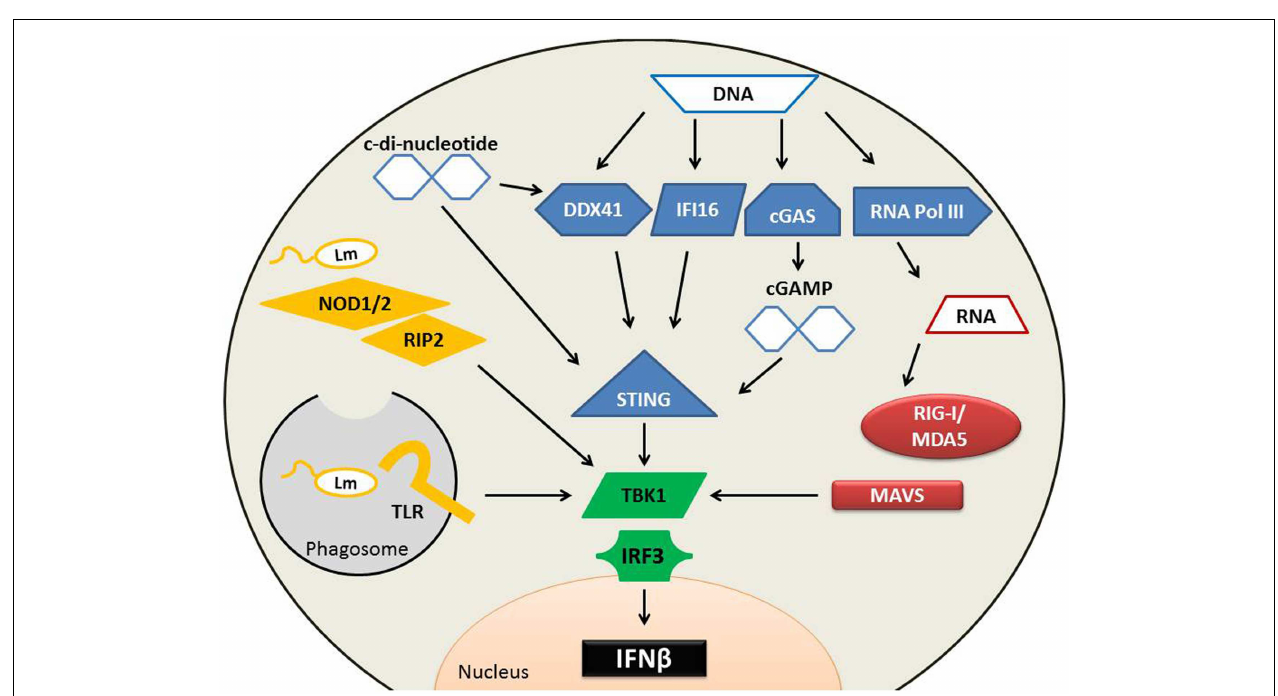
FIGURE 1 | Pathways implicated in type I IFN production following L. monocytogenes infection . Several cytosolic receptors are able to recognize L. monocytogenes (Lm) microbial components to induce type I IFN production. (Yellow) EndosomalTLRs recognize a variety of Lm bacterial patterns including cell wall fragments, which can also stimulate NOD proteins. NOD proteins require association with RIP2 to activate TBK1. Lm secretes RNA, DNA, and cyclic-di-nucleotides. Secreted RNA (red) binds to RIG-I or MDA5, both of which associate with MAVS. Cytosolic DNA (blue) can alternatively be converted into RNA by